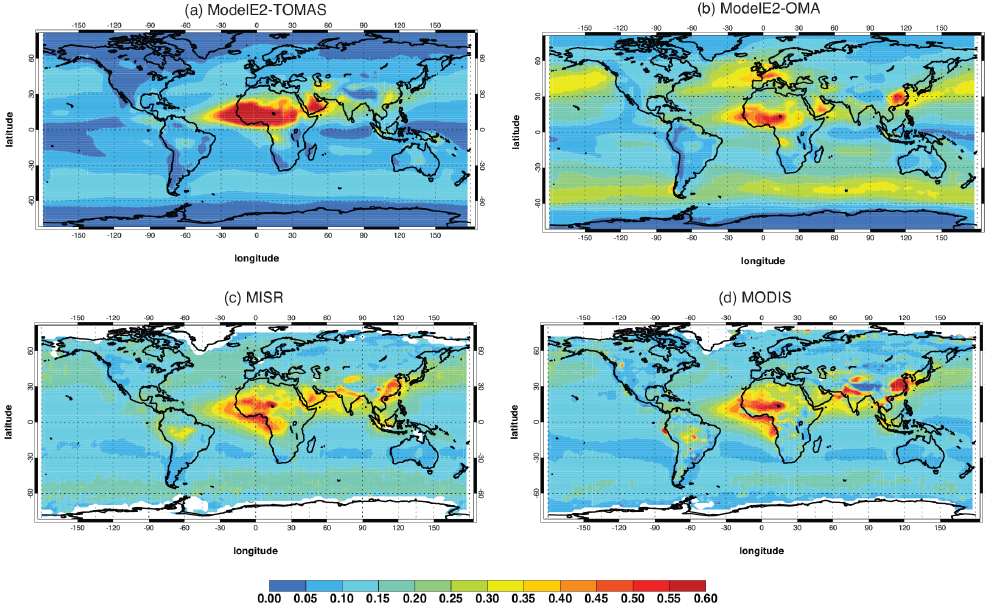
Figure 17. Global distributions of the annual-mean AOD from (a) ModelE2-TOMAS, (b) ModelE2-OMA, (c) MISR, and (d) MODIS. See Sect. 5.4 for the details of the MISR and MODIS AOD